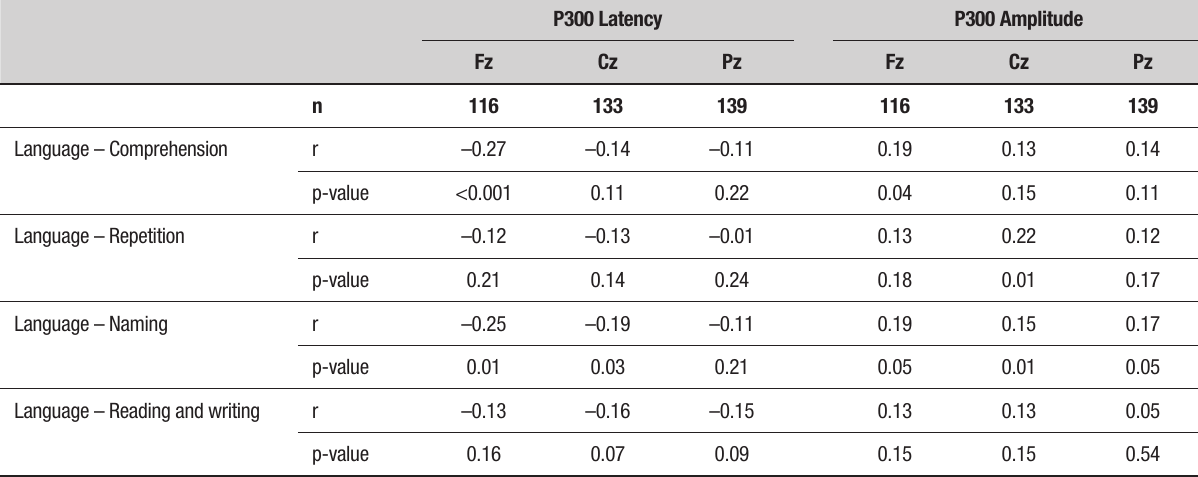
Spearman’s correlation test. Table 2. Correlation matrix between P300 latency and amplitude and performance of elderly individuals on language tasks assessed by the ACE-R (n=149). São Carlos, SP, Brazil,